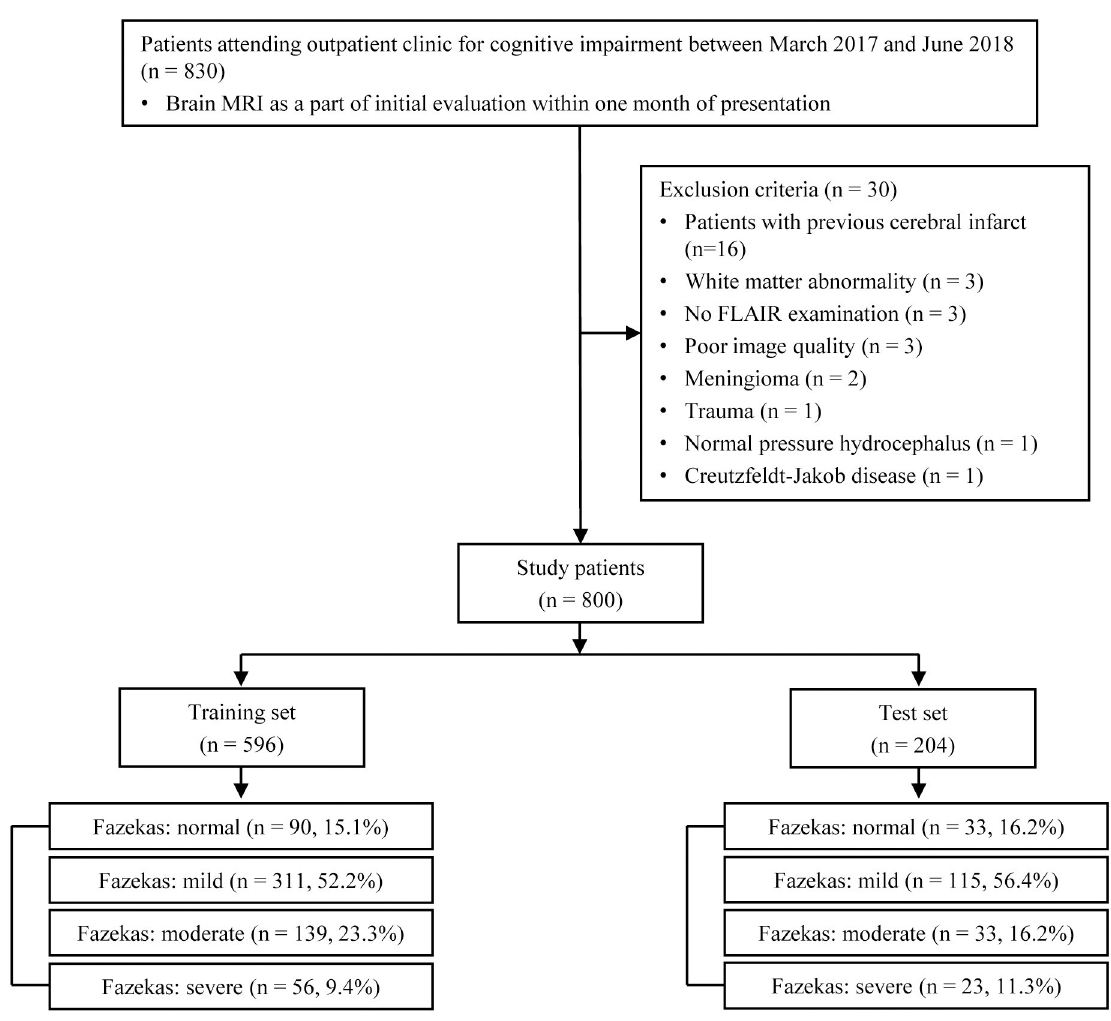
Fig 3. Flow diagram showing the selection process of patients and their Fazekas scale. FLAIR, fluid-attenuated inversion recovery; MRI, magnetic resonance